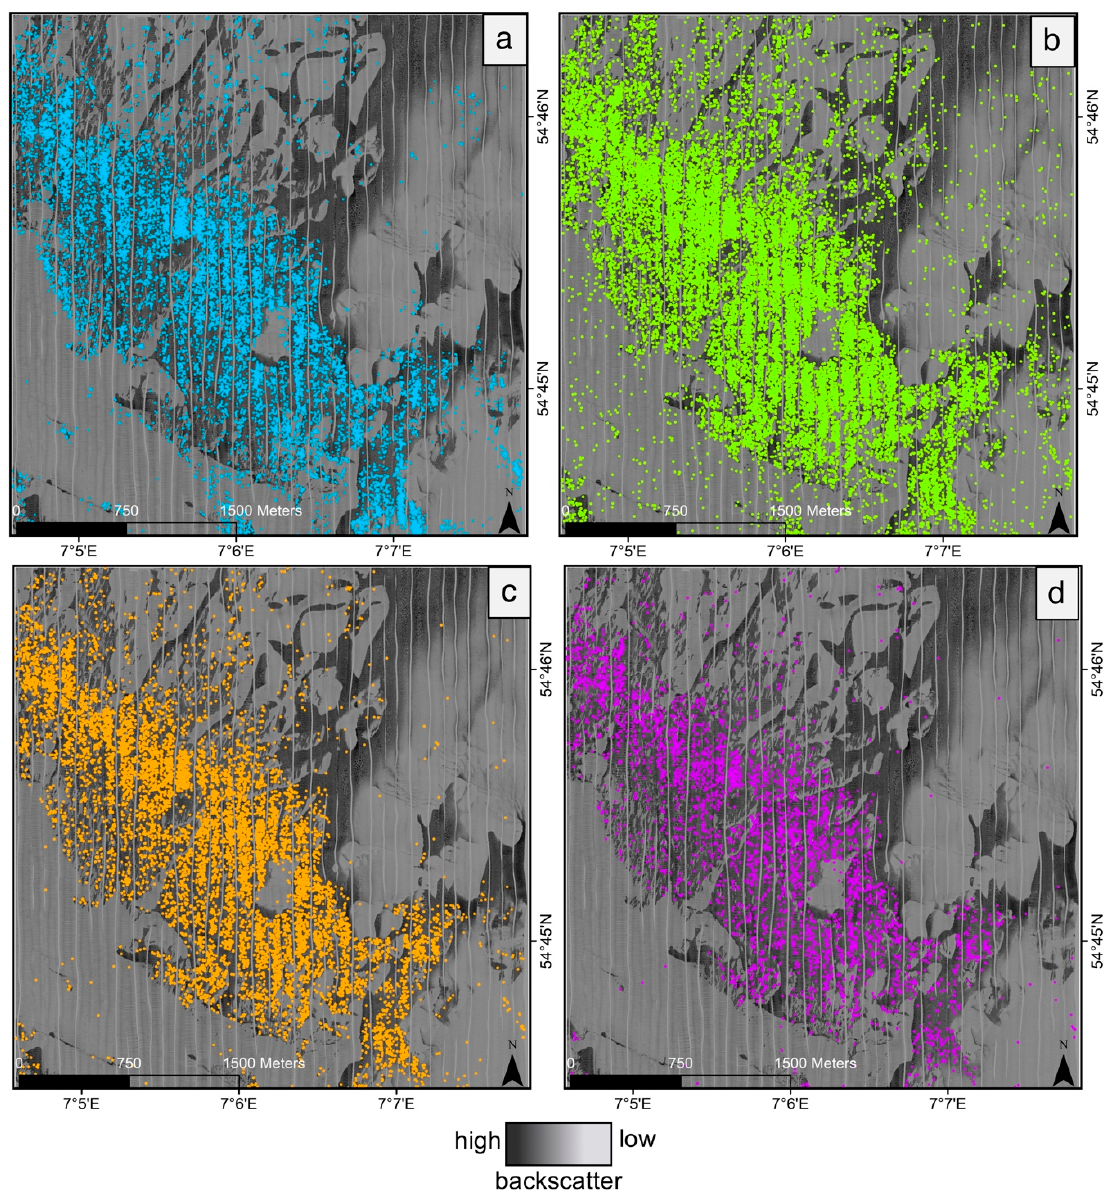
Figure 5. Stones and detections on an SSS mosaic (25-cm resolution) with different methods: ( a ) manually tagged stones, and automatic detections on an SSS mosaic with 64 grey values and a detector threshold value of 6 ( b ), 12 ( c ) and 20 ( d ).